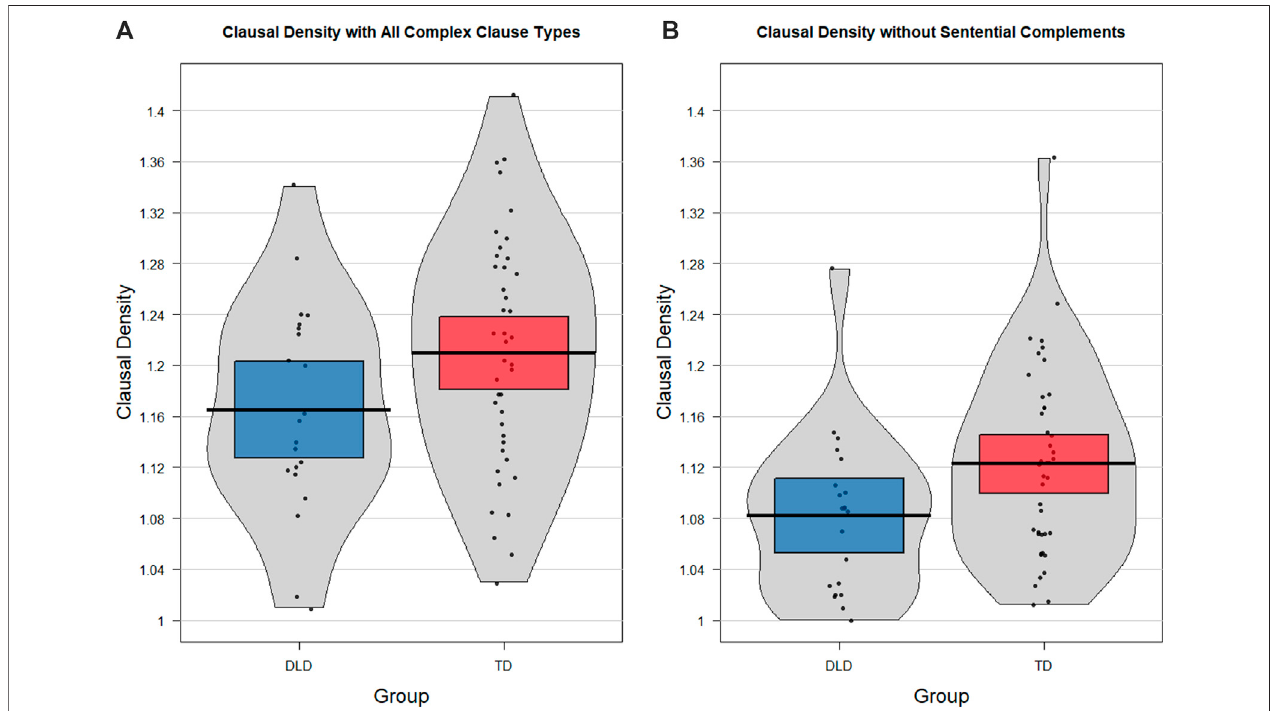
FIGURE 4 | Clausal density by group. The clausal density measure in the (A) was calculated across all complex clause types, whereas, sentential complement clauses were omitted from the clausal density measure in the (B) . Note: The thick black line represents the median for each group, the colored rectangle is the interquartile range; and the grey shape represents the distribution of all data points, with greater width indicating a higher frequency of data points in that region.